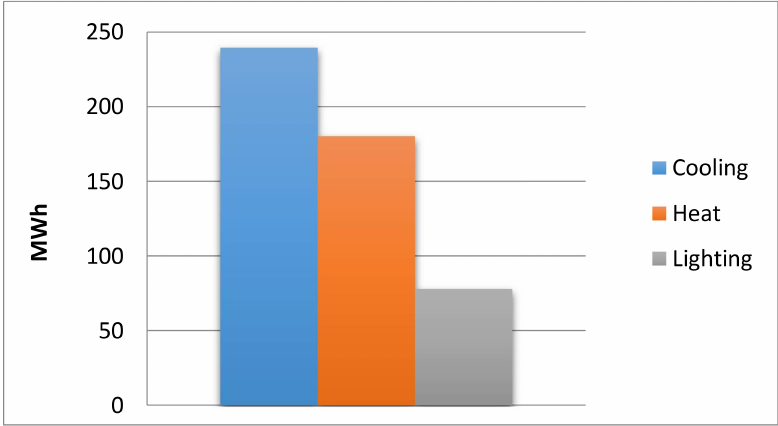
Figure 11. Energy consumption by